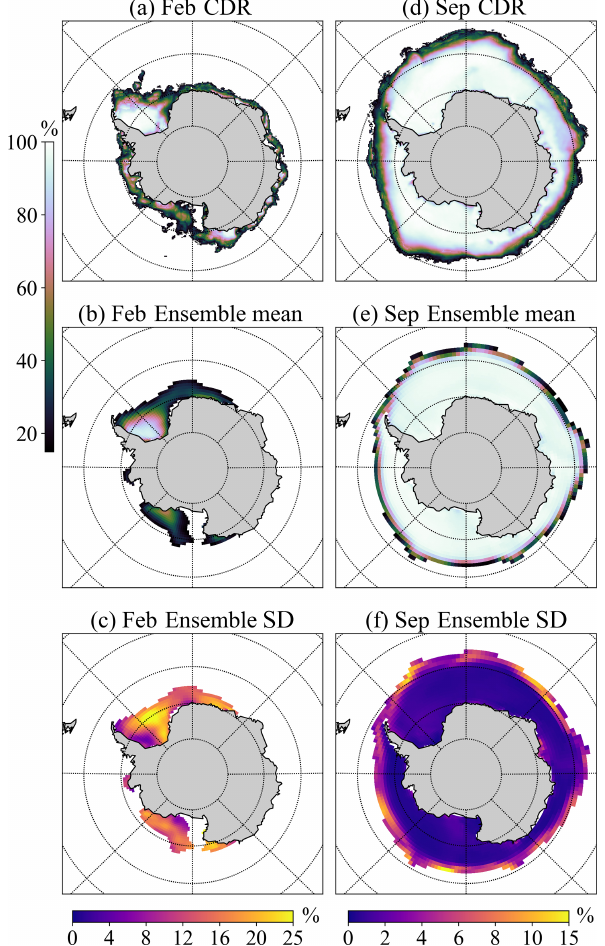
Figure B2. (a, b) Observed (NOAA/NSIDC Climate Data Record of Passive Microwave Sea Ice Concentration, version 4; CDR) and model ensemble mean February SIC climatologies (only SIC > 15% are shown). (c) Standard deviation of all model runs. (d–f) The same as (a–c) but for